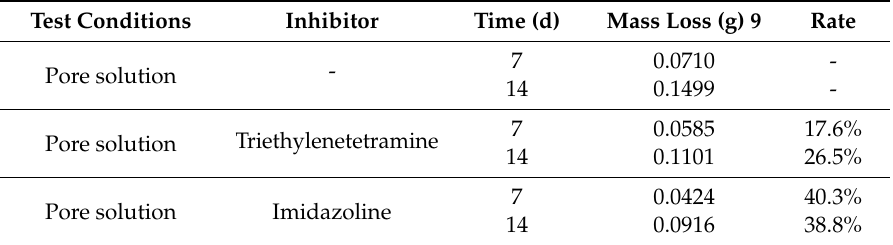
Table 1. Corrosion inhibition rates of different inhibitors in simulated pore fluid of concrete.